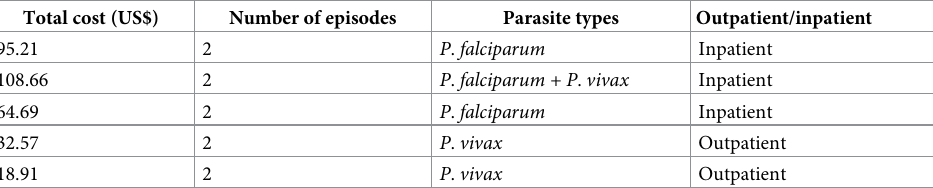
Table 4. Total costs incurred by women who experienced more than one episode during